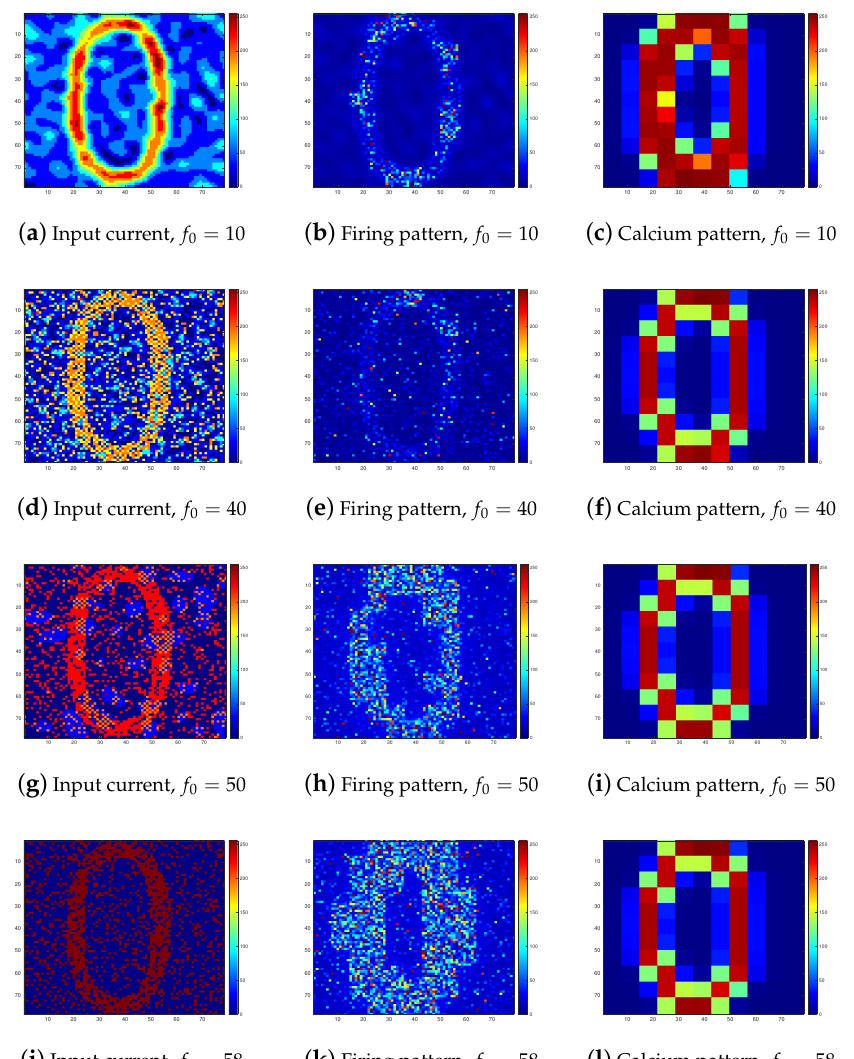
Figure 7. Snapshots for l = 8. The left panel displays the input current after being transformed by the low-pass filter at testing. The middle panel displays the firing pattern of neurons at t = 2.1 s. The right panel displays the calcium pattern of astrocytes at t = 2 s. In each sub-figure, the x - and y -axis denote the positional indices of the image. The colorbar describes the level of the input current, neuronal firing and astrocytic calcium concentration. The level has been scaled in the range 0–255 for visualization. The model exhibits very similar calcium patterns irrespective of the filter thresholds. From the first and the second column, we observe that f 0 = 10 smooths the picture and prevents over-firing of neurons; f 0 = 40 corrupts the picture to a certain degree; f 0 = 58 results in over-firing; f 0 = 50 is somewhere in the middle. Therefore, the performances of f 0 = 40 and f 0 = 58 are less